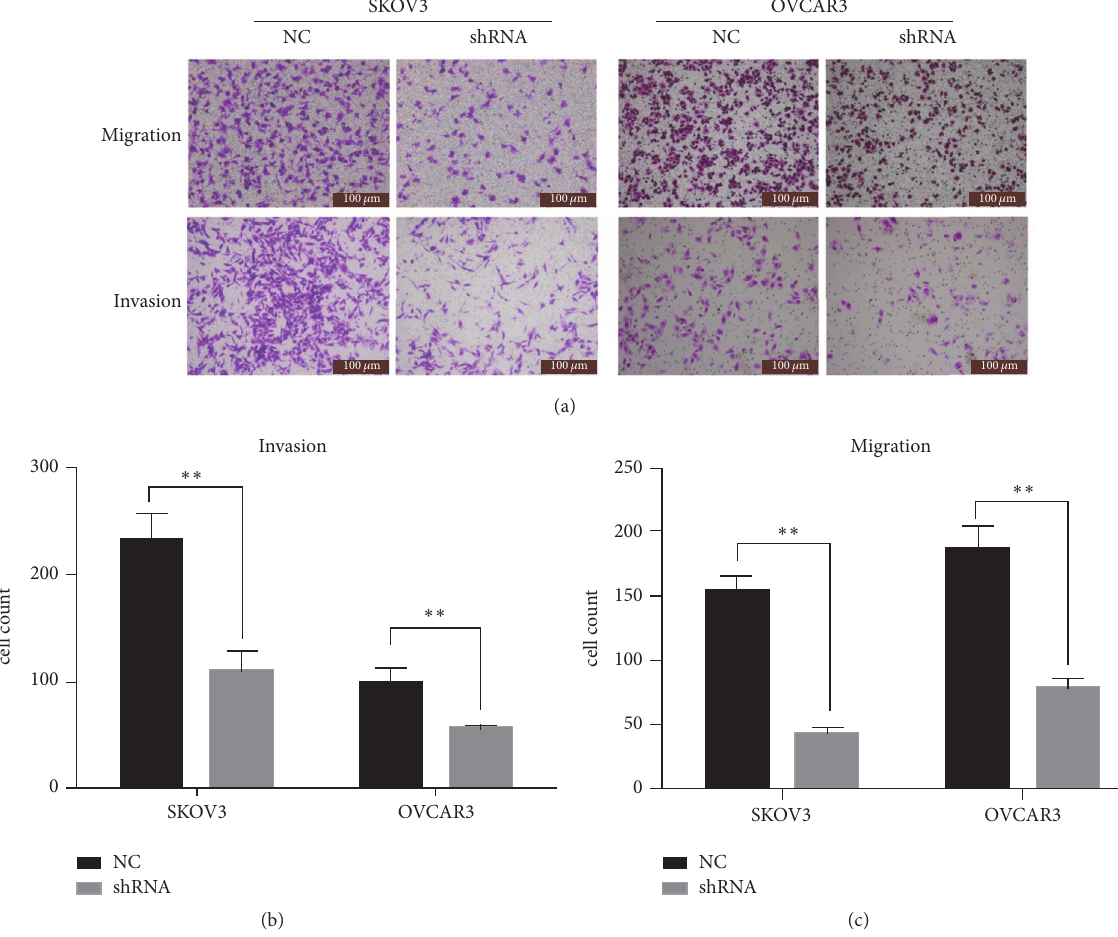
Figure 5: Knockdown of MIR4697HG inhibits cell migration and invasion in SKOV3 cells and OVCAR3 cells. (a) Both SKOV3 cells and OVCAR3 cells with (shRNA group) or without (NC group) specific shRNA transfections were subject to transwell migration and invasion assays. The transmigrated cells underneath the membrane were stained with crystal violet and photographed under a light microscopy. Five representative images were randomly selected for each group. (b) Invaded cells were counted in both SKOV3 cells and OVCAR3 cells with MIR4697HG knockdown (shRNA group) or not (NC group). Data were collected from five randomly selected fields and averaged for each group. (c) Migrated cells were counted in both SKOV3 cells and OVCAR3 cells with MIR4697HG knockdown (shRNA group) or not (NC group). Data were collected from five randomly selected fields and averaged for each group. ∗∗ 𝑝 < 0.01